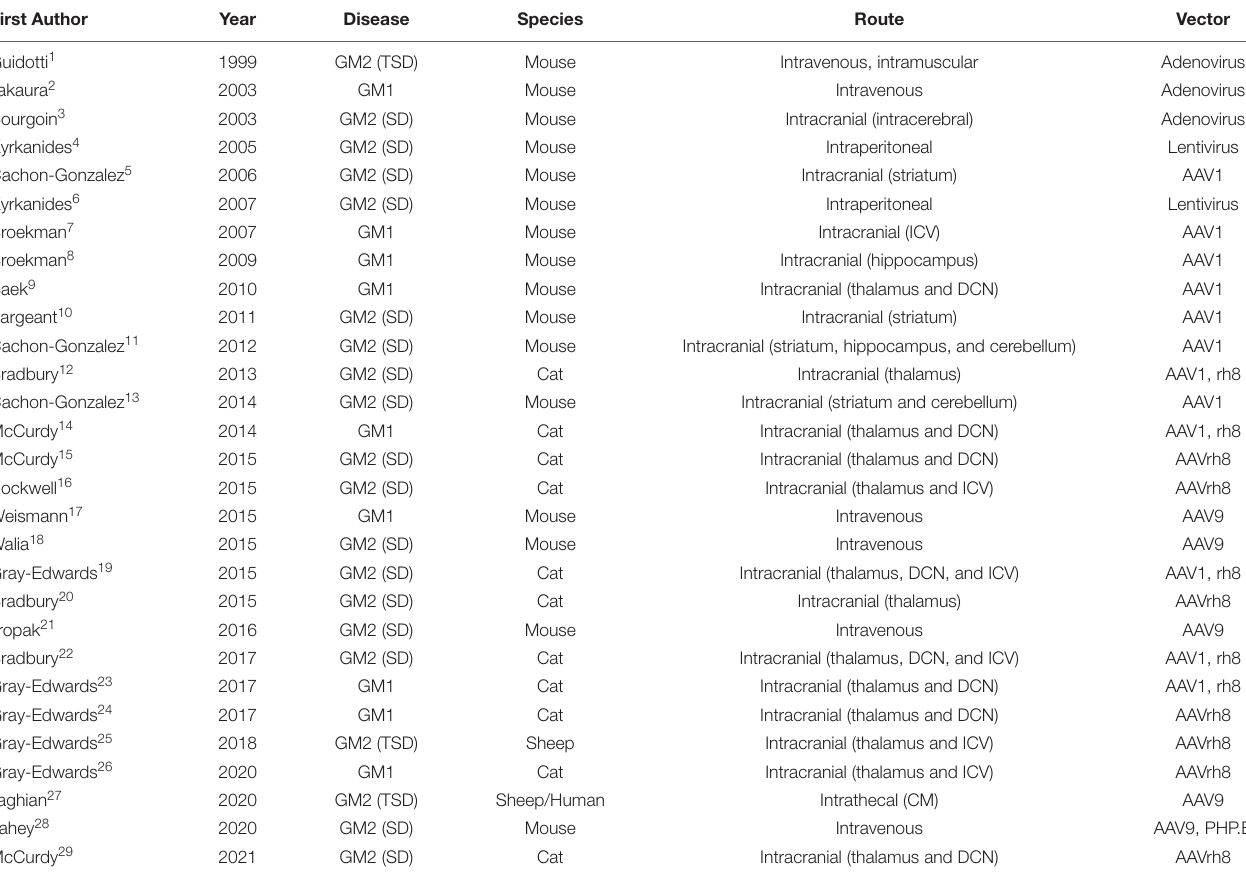
TABLE 2 | Studies involving animal models treated with gene